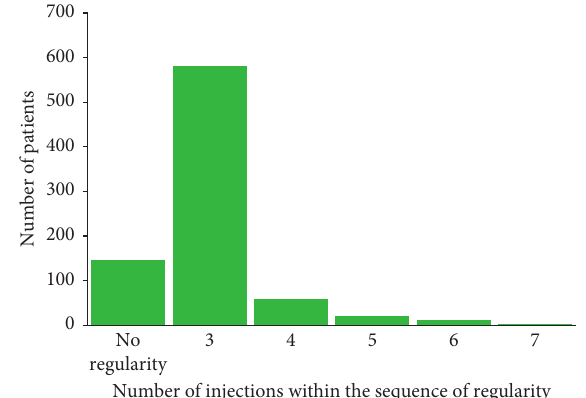
Figure 9: Number of injections within the sequence of regularity. Note: a sequence of injections was defined as regular if at least 3 injections occurred within the same individual time frame ( ± 10 days) and with the sequence starting on the 6th visit at the